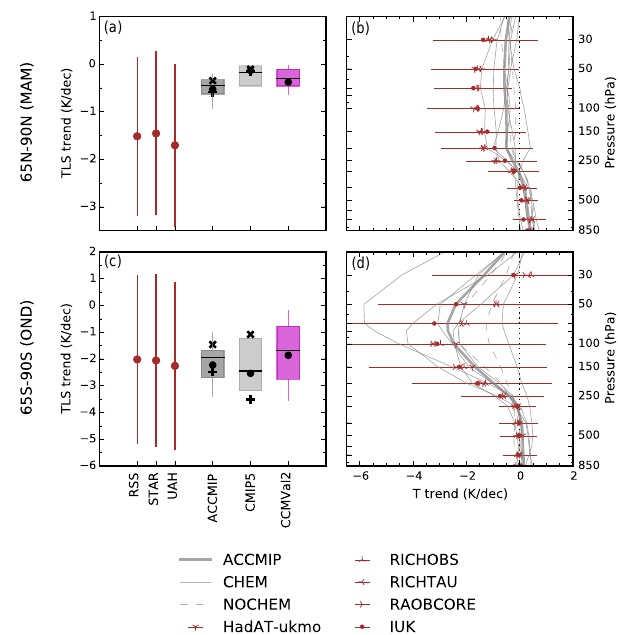
Figure 6. Temperature trends from 1980 to 2000 (Kdec − 1 ) . Fig- ures (a) and (c) represent MSU temperature lower stratosphere (TLS) for MAM in the Arctic and for OND in the Antarctic. The box, whiskers, line, dot, “plus”, and “cross” symbols show the in- terquartile range, 95% range, median, multi-model mean, CHEM, and NOCHEM means respectively, for the ACCMIP (light grey), CMIP5 (dark grey) and CCMVal2 (magenta) models. Figures (b) and (d) represent vertically resolved temperature ( T ) trends for the ACCMIP simulations (light grey). Observational data sets are rep- resented by error bars indicating the 95% confidence intervals (one